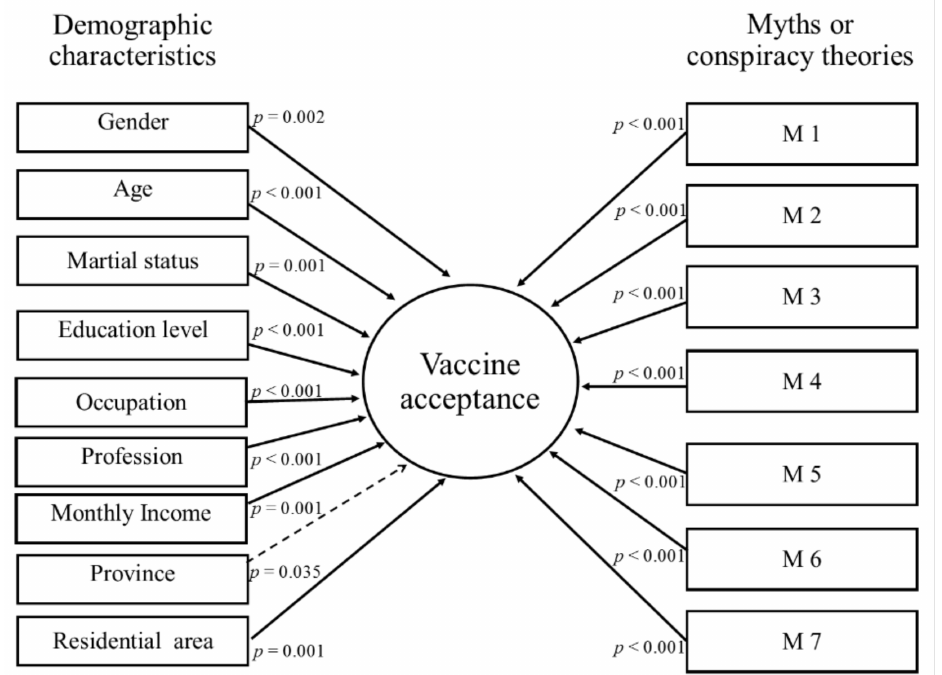
Figure 3. Association of COVID-19 vaccine acceptance with the demographic characteristics and myths. A solid line indicates a significant association ( p < 0.05). A dashed line indicates a